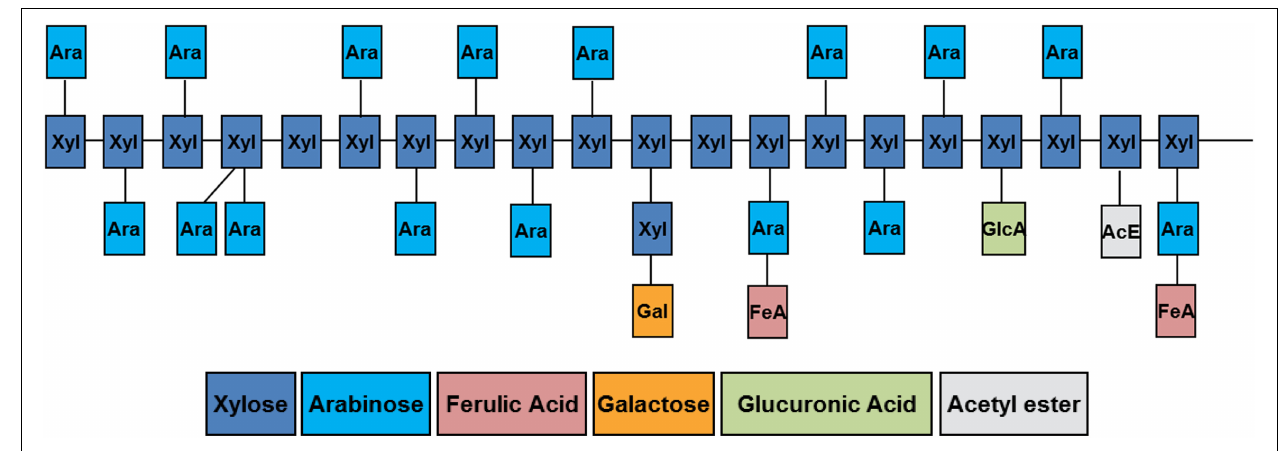
FIGURE 1 | Diagrammatical representation of structural features found in heteroxylans of the grasses. Details of the linkage types involved in the polysaccharides are outlined in the text. Figure prepared by Dr Hunter Laidlaw.